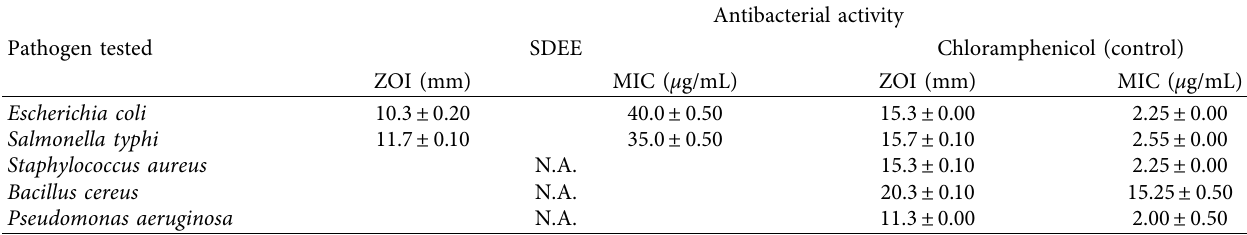
Table 3: Antibacterial activity of the saponifed diethyl ether extract pili pulp oil. Pathogen